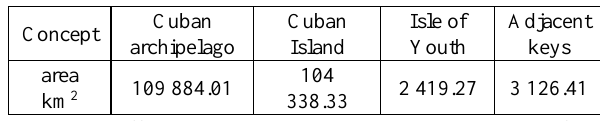
Table 1. Official data published in the Statistic yearbook of